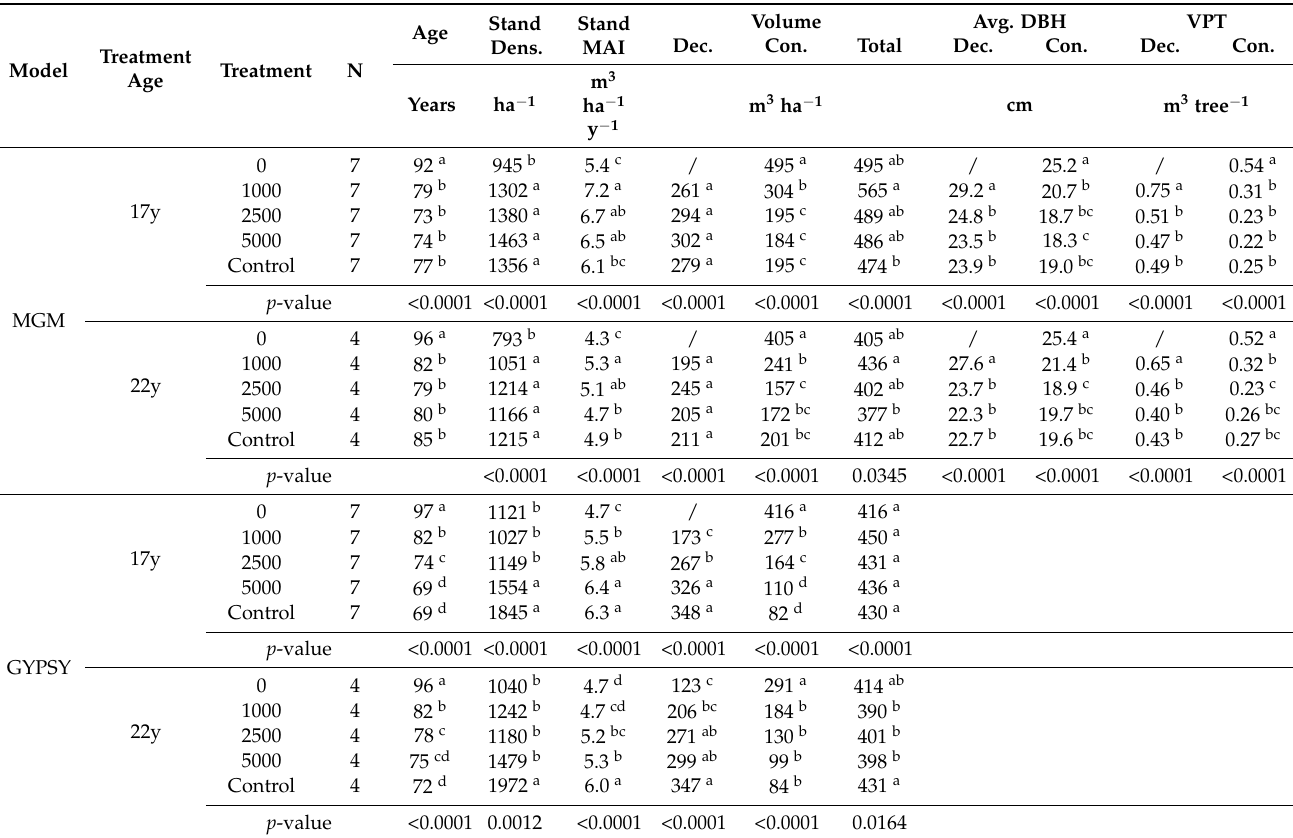
Table 4. Summary of treatment means for culmination age yields predicted by two forest growth and yield models (MGM and GYPSY) by stand age at thinning. Culmination age is determined for total (stand) MAI with “15/10” utilization standards in use. N is sample size (number of plots). VPT is merchantable volume per tree. Different letters show significantly different treatments within treatment age determined using Tukey’s post-hoc test (Bonferroni’s adjustment) after mixed-model